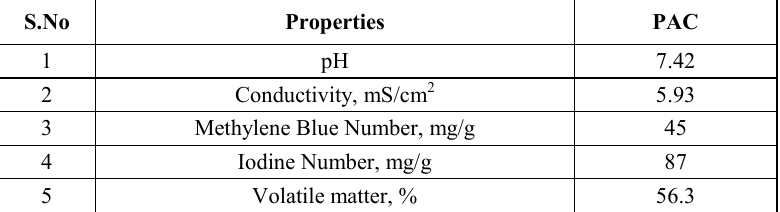
Table 1: Physico – Chemical characteristics of PAC.